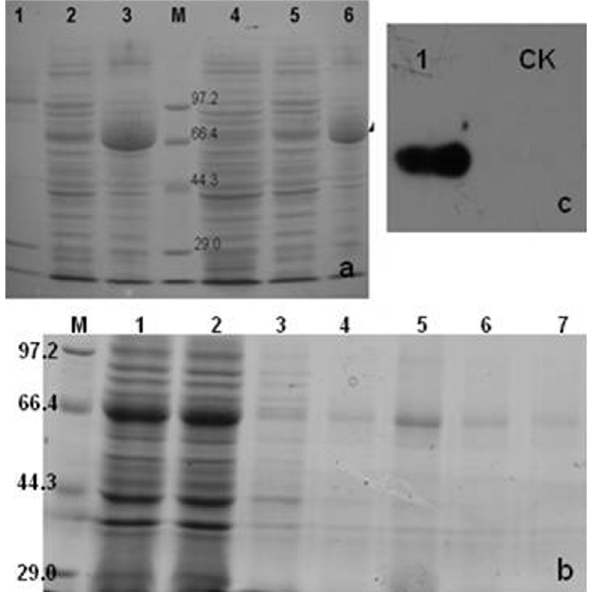
Figure 3 - Prokaryotic expression and western blot results of AcSERK3. (A) SDS-PAGE analysis of the expression product of pET-30a-AcSERK3 in E. coli. Lanes: M - low molecular mass marker, 1 - supernatant of cells carrying the pET30a vector, 2 - supernatant of non-induced cells carrying the pET30a- AcSERK3 vector, 3 - supernatant of induced cells carrying the pET30a- AcSERK3 vector, 4 - precipitate of induced cells carrying the pET30a vector, 5 - precipitate of non-induced cells carrying the pET30a- AcSERK3 vector, 6 - precipitate of induced cells carrying the pET30a- AcSERK3 vector. (B) Purification of expressed pET30a- AcSERK3 pro- tein. Lanes: M - low molecular mass marker, 1 - soluble fraction of in- duced cells containing pET30a-AcSERK3, 2 - pET30a-AcSERK3 flow- through, 3 - wash buffer, 4-7 - first, second, third and fourth washes with elution buffer. (C) Western blot of His6-AcSERK3 fusion protein. Lanes: CK - negative control (purified product of E. coli cells containing the pET30a vector), 1 - purified recombinant